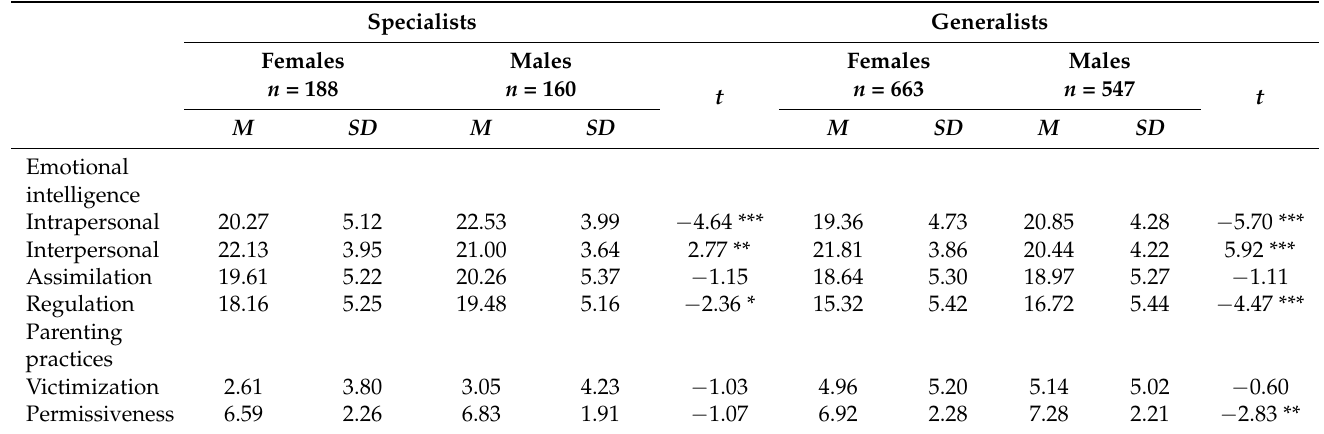
Table 2. Gender differences in emotional intelligence and parenting practices by aggressor